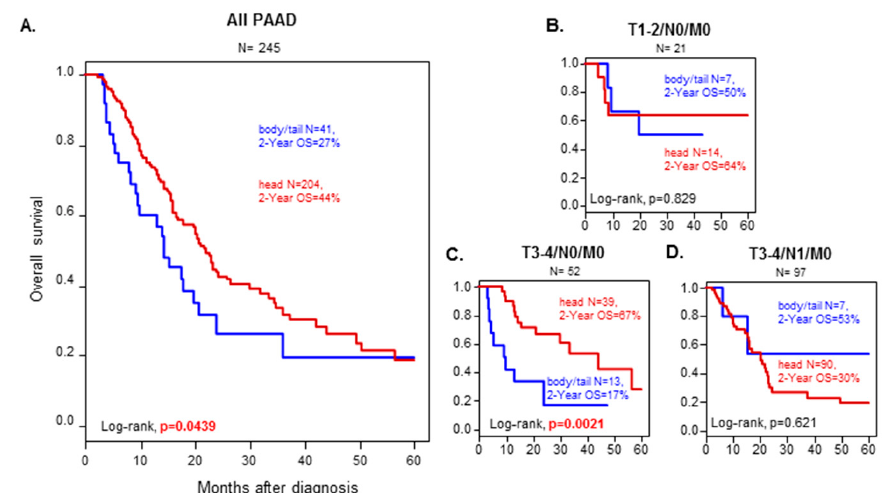
Figure 1. Overall survival in Head or Body / Tail tumors. Kaplan–Meier overall survival (OS) curves according to PDAC location ( A ). All pancreatic ductal adenocarcinoma (PDAC) and ( B ) T1 / 2 N0 M0 tumors. ( C ) T3 / 4N0M0 tumors. ( D ) T3 / 4 N1 M0 tumors. T1 / 2N1M0 tumors have less than 10 samples in total and were not graphed). Head samples are in yellow. Body / Tail samples are in blue. The p -values (log-rank test) for the comparison between the two classes within each molecular subtype are indicated.